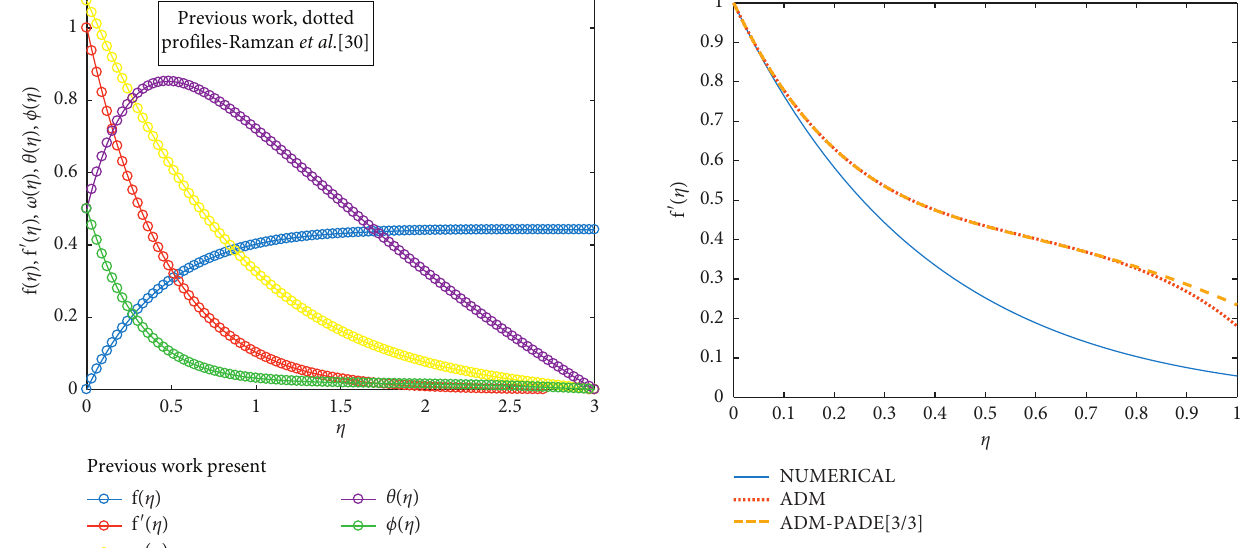
Figure 4: Comparative plot of velocity profile.